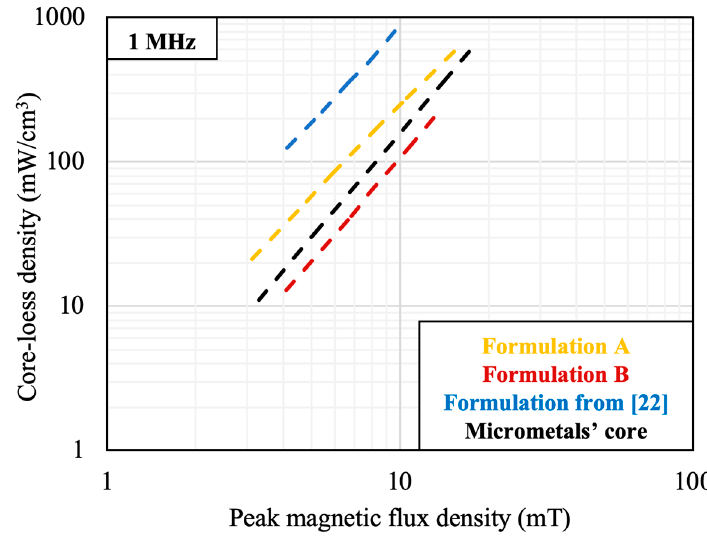
Figure 3. Plots of core loss density versus magnetic flux density at 1 MHz of Formulations A and B, a formulation from [22], and that of a Power Conversion Material-8 core from Micrometals.